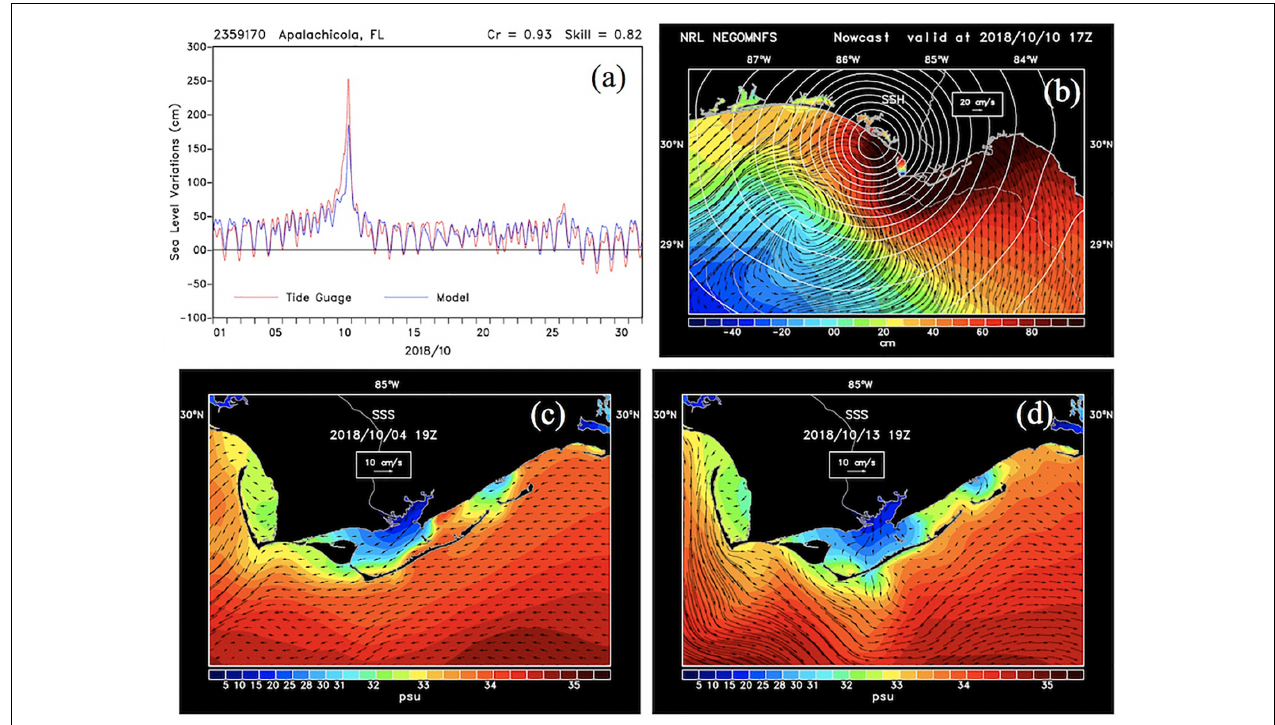
FIGURE 3 | NCOM model outputs. (a) Sea level variations from model simulations and the NOAA National Ocean Service (NOS) tide gauge station located in Apalachicola, Florida; (b) model simulation of surface elevation superimposed by surface currents and air pressure for October 10, 2018 during Hurricane Michael landfall just east of ApB. (c,d) Sea surface salinity (SSS) and superimposed by de-tided surface currents on October 4 and 13, 2018.